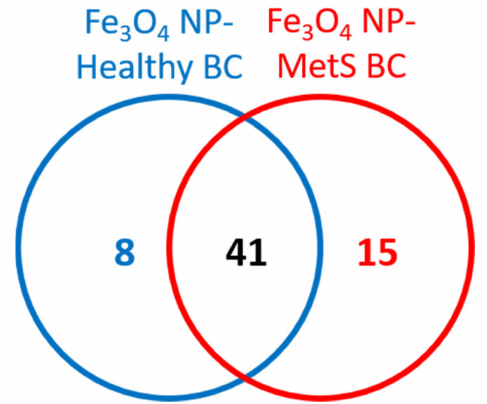
Figure 1. Comparison of BC composition between healthy and MetS conditions. Proteins identified as present in healthy BC were compared to proteins within the BC formed from MetS BALF. Venn diagrams were used to illustrate the number of unique and common proteins. A comprehensive list of these proteins and relative abundance of all proteins identified in each BC can be found in Table S1.